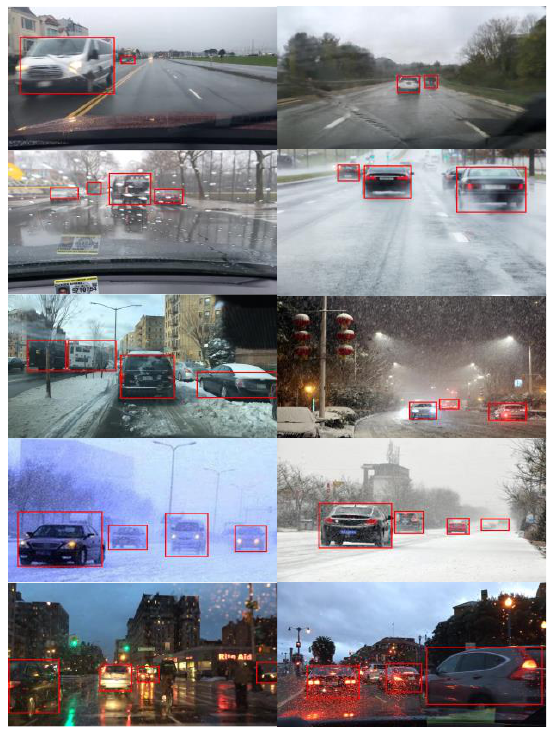
Figure 18. Effect diagram of detection under complex driving environment (rainy, snowy, and night with light interference).